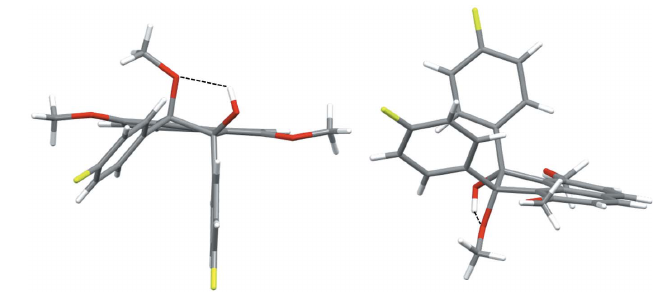
Figure 2 Top (left) and side view (right) of the title compound showing the